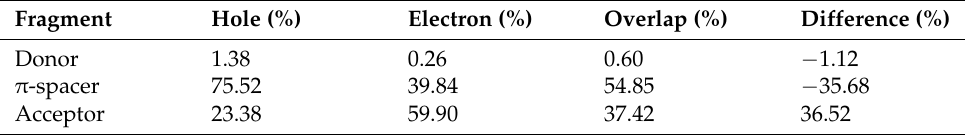
Table 4. Fragment contribution to electron–hole overlap in O1